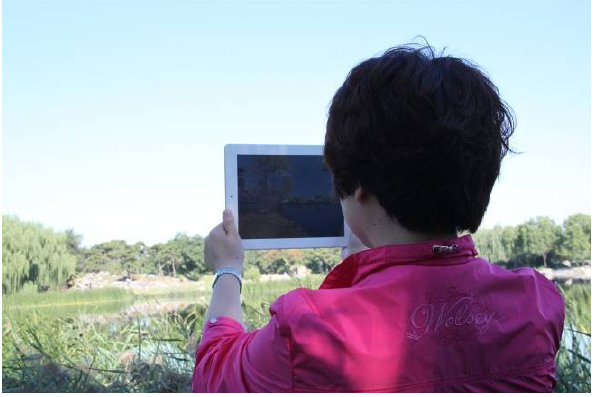
Figure 5. Visitors looking at AR reconstruction in an